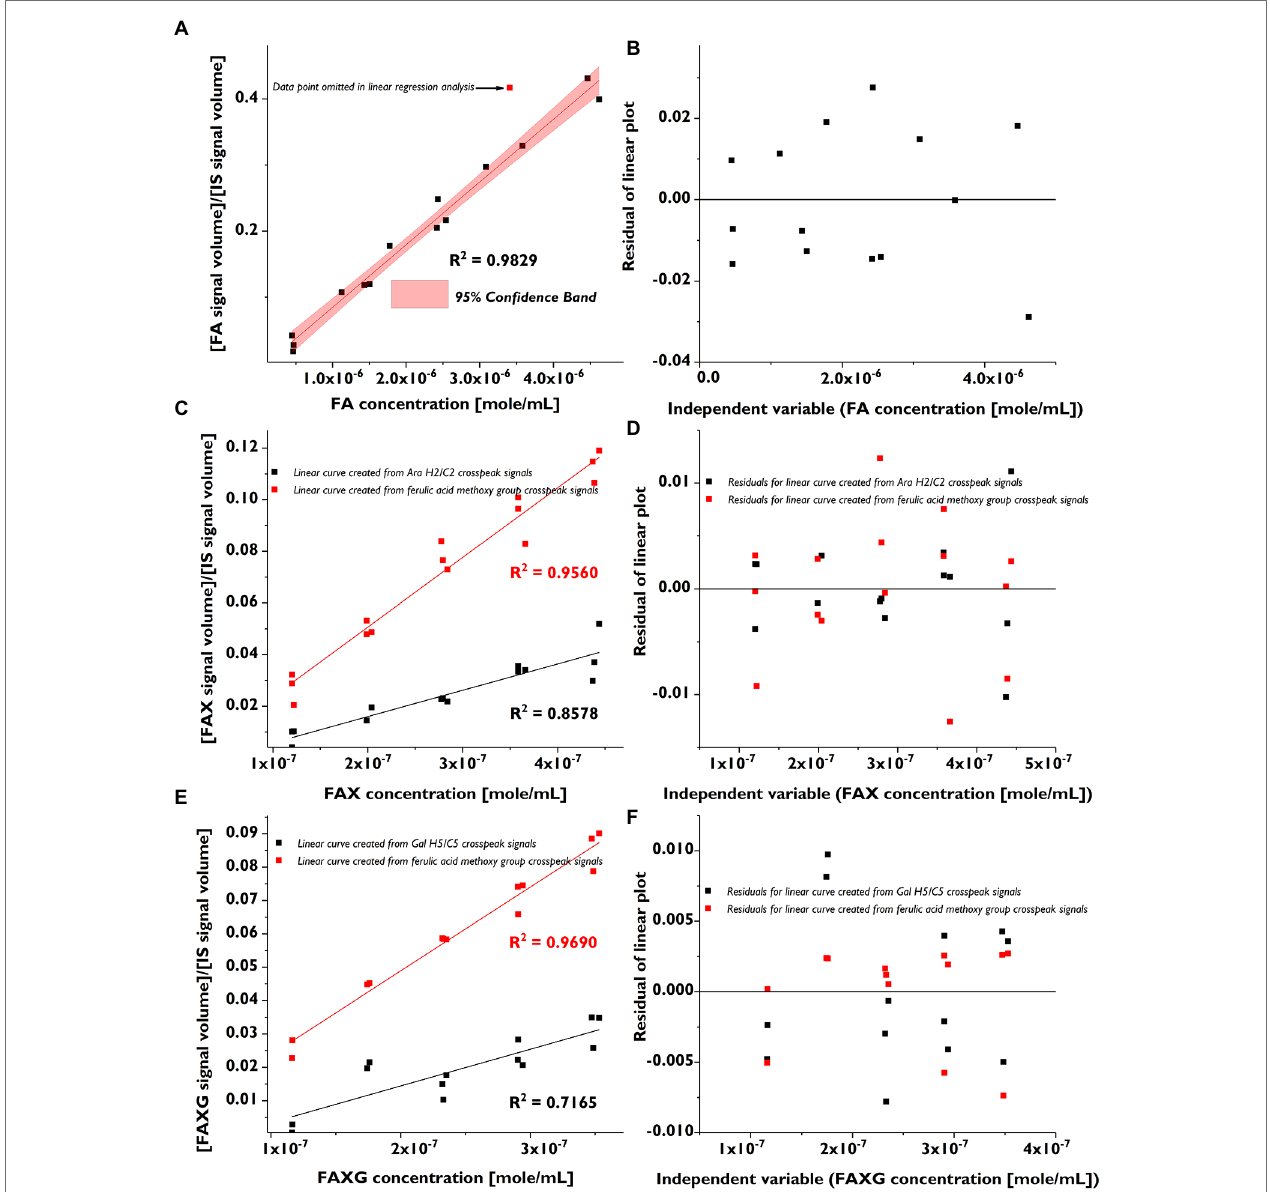
FIGURE 2 | Linear calibration curves (in triplicate) and corresponding residual plots of feruloylated side-chain standard compounds following volume integration of selected HSQC cross-peaks. (A) : Linear calibration curve for FA. (B) : Residual plot for FA calibration curve. (C) : Linear calibration curve for FAX (black) created from the quantification cross-peak signal and the curve created from the ferulate methoxy cross-peak signal (red). (D) : Residual plots for FAX calibration curve (black) created from the quantification cross-peak signal and for the curve created from the ferulate methoxy cross-peak signal (red). (E) : Linear calibration curve for FAXG (black) created from the quantification cross-peak signal and the curve created from the ferulate methoxy cross-peak signals (red). (F) : Residual plots for FAXG calibration curve (black) created from the quantification cross-peak signal and for the curve created from the ferulate methoxy cross-peak signal (red). FA, 5- O - trans - feruloyl- l -arabinofuranose; FAX, β - d -xylopyranosyl-(1 → 2)-5- O - trans -feruloyl- l -arabinofuranose; FAXG, α - l -galactopyranosyl-(1 → 2)- β - d -xylopyranosyl-(1 → 2)-5- O - trans -feruloyl- l -arabinofuranose; HSQC, heteronuclear single quantum coherence spectroscopy. IS, internal